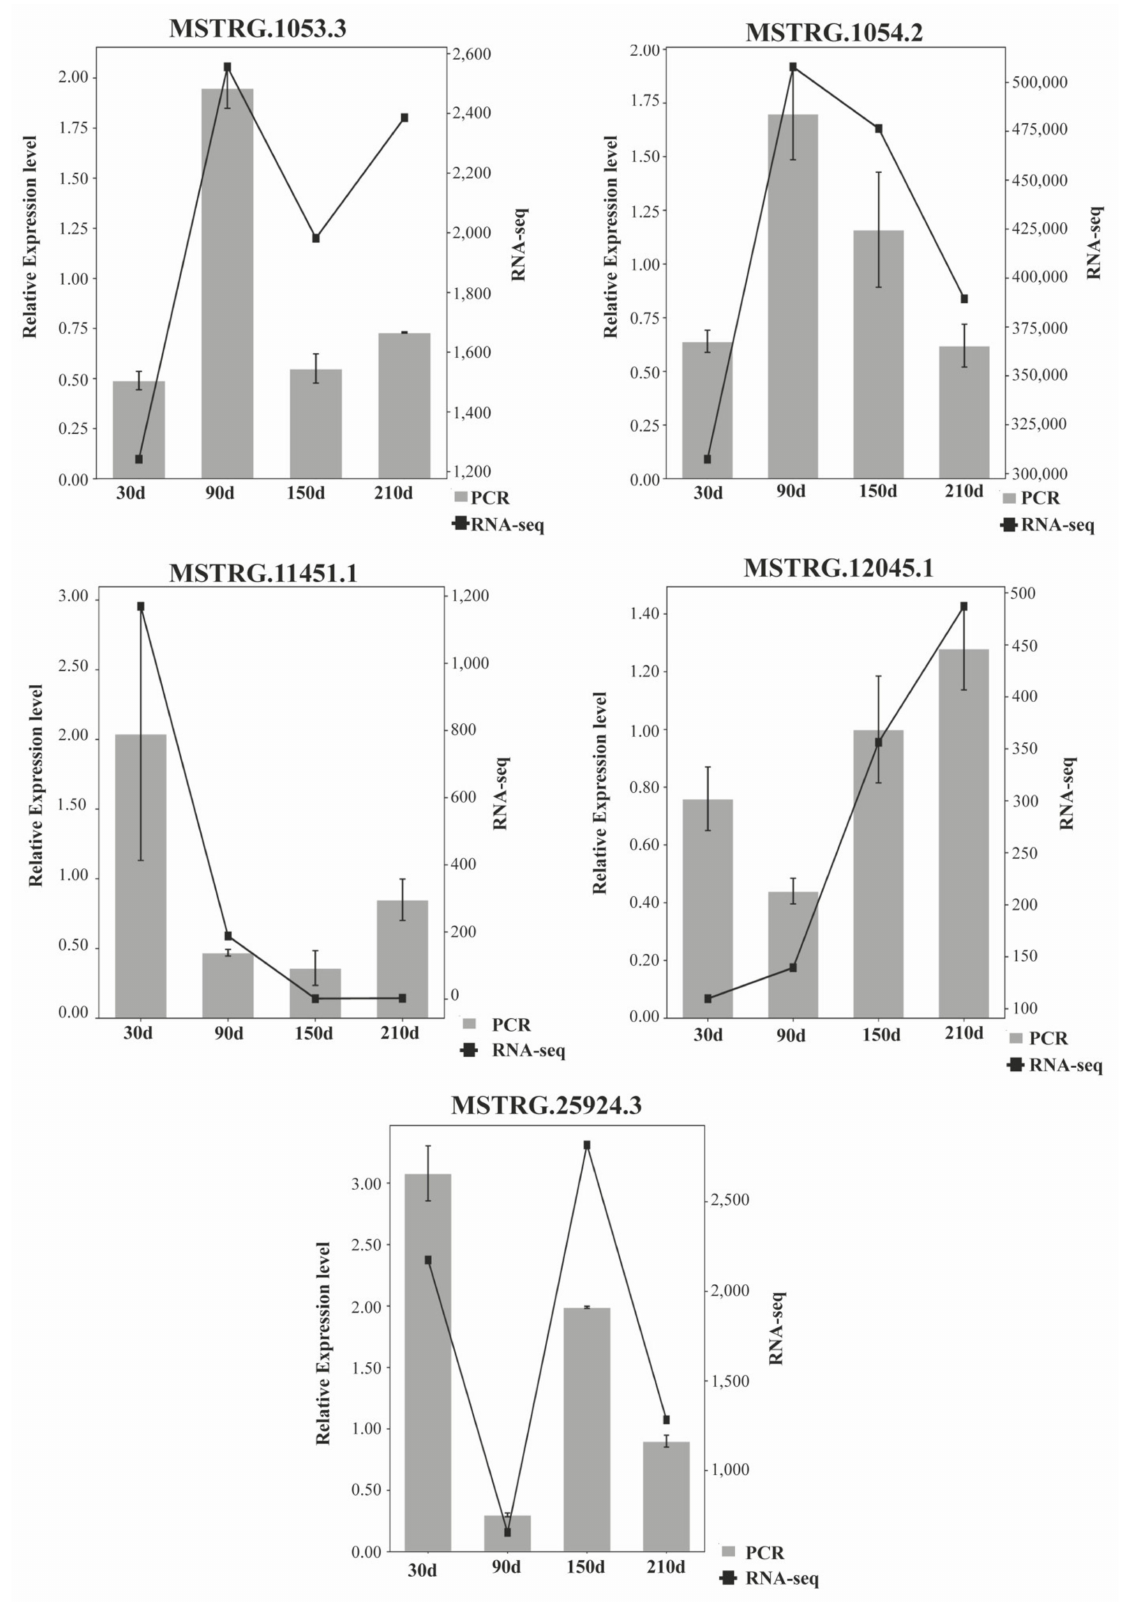
Figure 6. Expression patterns of MSTRG.1053.3, MSTRG.1054.2, MSTRG.11451.1, MSTRG.12045.1, and MSTRG.25924.3 compared to expression patterns in the